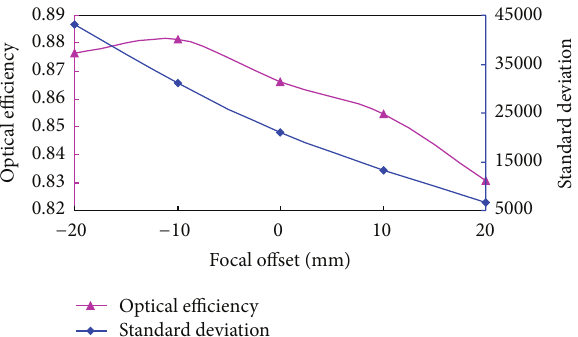
Figure 9: The optical properties of cavity at different focus offset.